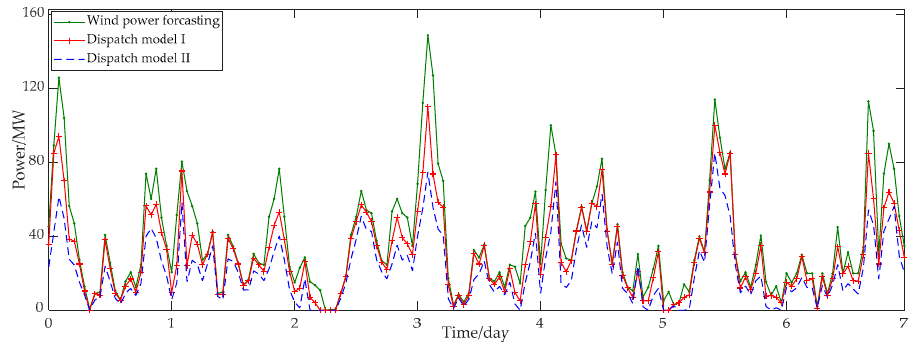
Figure 8. Comparison of wind power accommodation.